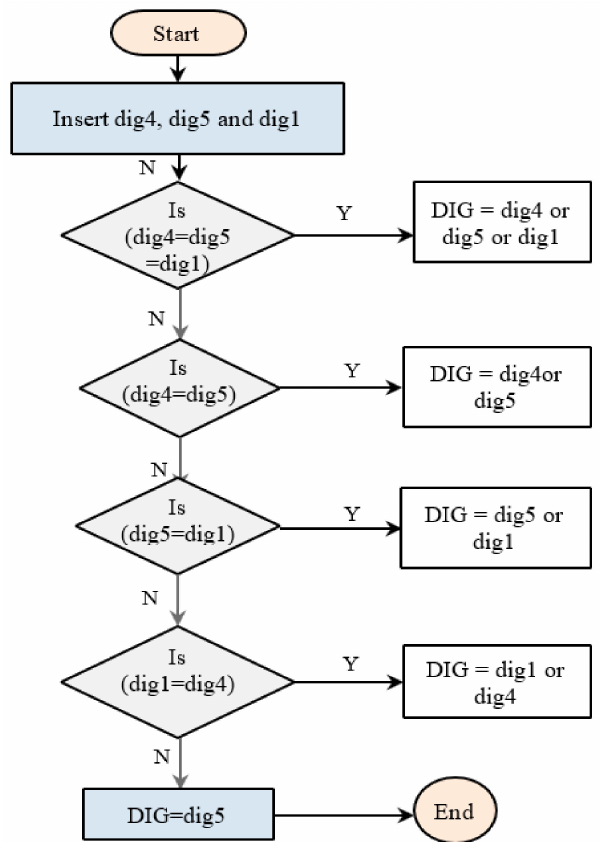
Figure 3. Flowchart procedure of technique no.